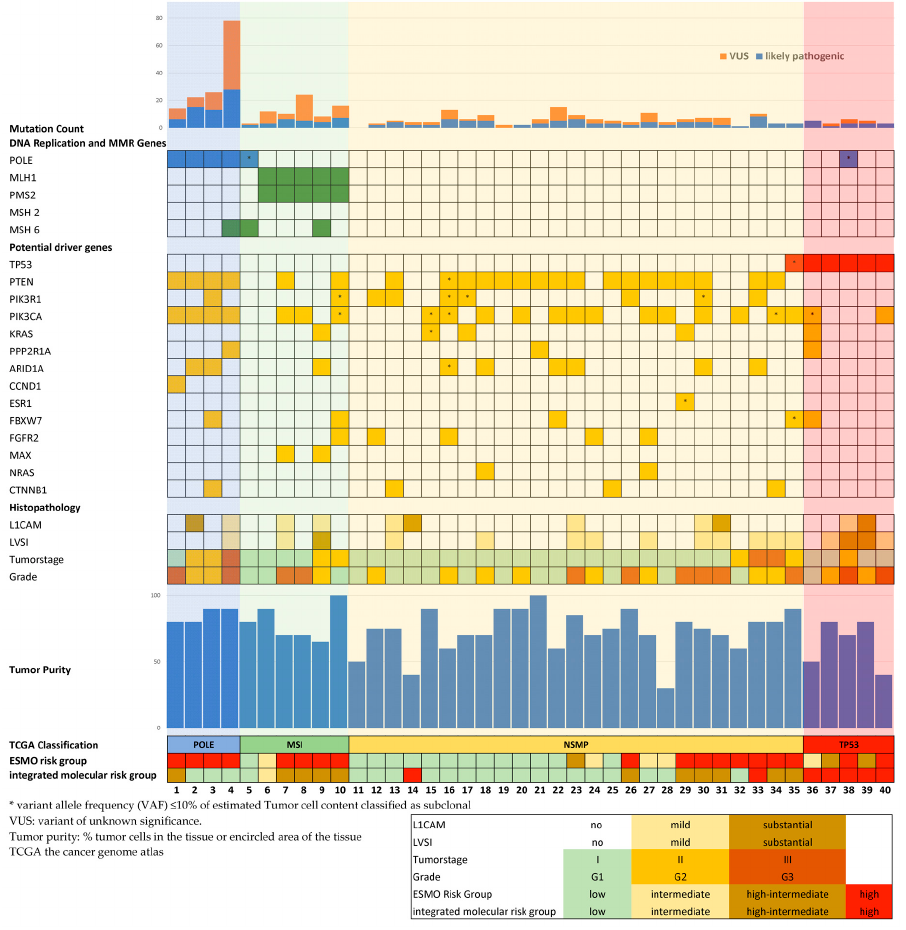
Figure 1. Molecular and histopathologic profiles of 40 patients with endometrioid adenocarcinoma of the endometrium.